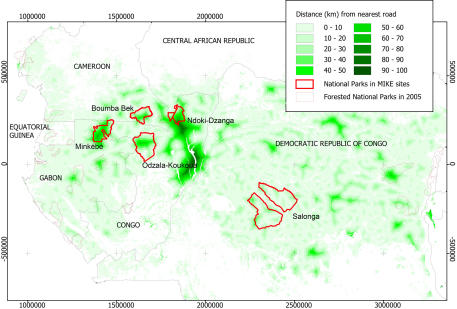
National Parks in MIKE Sites, the Forested National Parks of Central Africa, and Their Isolation from Roads